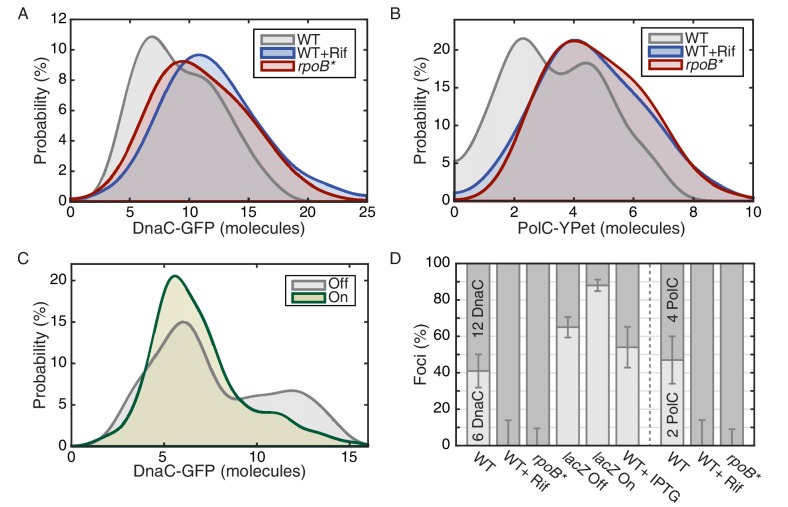
The effect of perturbations to transcription on stoichiometry distributions.(A) Helicase complex stoichiometry under three conditions: Untreated (WT), rifampicin-treated (Rif) and rpoB* cells. Probability densities are represented as Kernel Density Estimates (KDEs). In contrast to WT (gray), in both rifampicin-treated (blue) and rpoB* (red) cells, a significant fraction of single-helicase complexes (6 DnaC molecules) are lost with all observations being consistent with two-helicase complexes (12 DnaC molecules). (N = 70–117) (B) Estimated PolC stoichiometry in untreated (gray), rifampicin-treated (blue), and rpoB* (red) cells (N = 81–125). The low stoichiometry peak is no longer resolvable after rifampicin treatment or in the rpoB* mutant background, implying increased stability of the polymerase. (Note: rifampicin treatment also increased the exceedingly high fluorescence population which was again removed for the purpose of fitting.) (C) The relative abundance of helicase complex stoichiometries in cells with an ectopic inducible head-on replication-transcription conflict (lacZ). An IPTG (induction)-dependent increase in the single-helicase stoichiometry was observed, consistent with the reduction in factory stoichiometry being conflict-induced. (N = 108–174) (D) Summary of stoichiometry for transcription-inhibition and ectopic-conflict experiments. Estimates for the relative abundance of first and second order stoichiometry sub-populations are determined by fitting the distributions of estimated stoichiometries (Figure 3—figure supplement 1, Table 2).